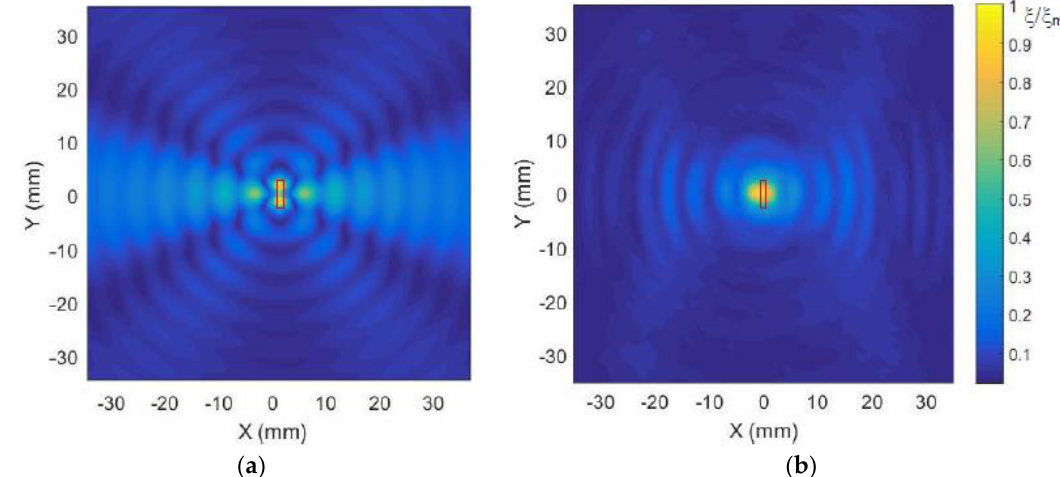
Figure 13. 2D spatial distributions of normal displacements ξ of the plastic film taking into account interference of the direct A 0 mode and additional wave caused by the wave propagating in air: ( a ) calculated; ( b ) measured. The presented amplitude values shown in the color bar were normalized with respect to the maximum value in the field.